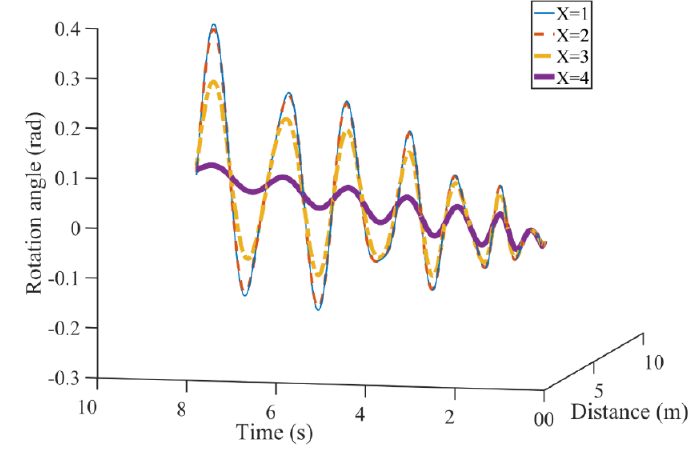
Figure 8. Impact of branching parameter on rotation angle.